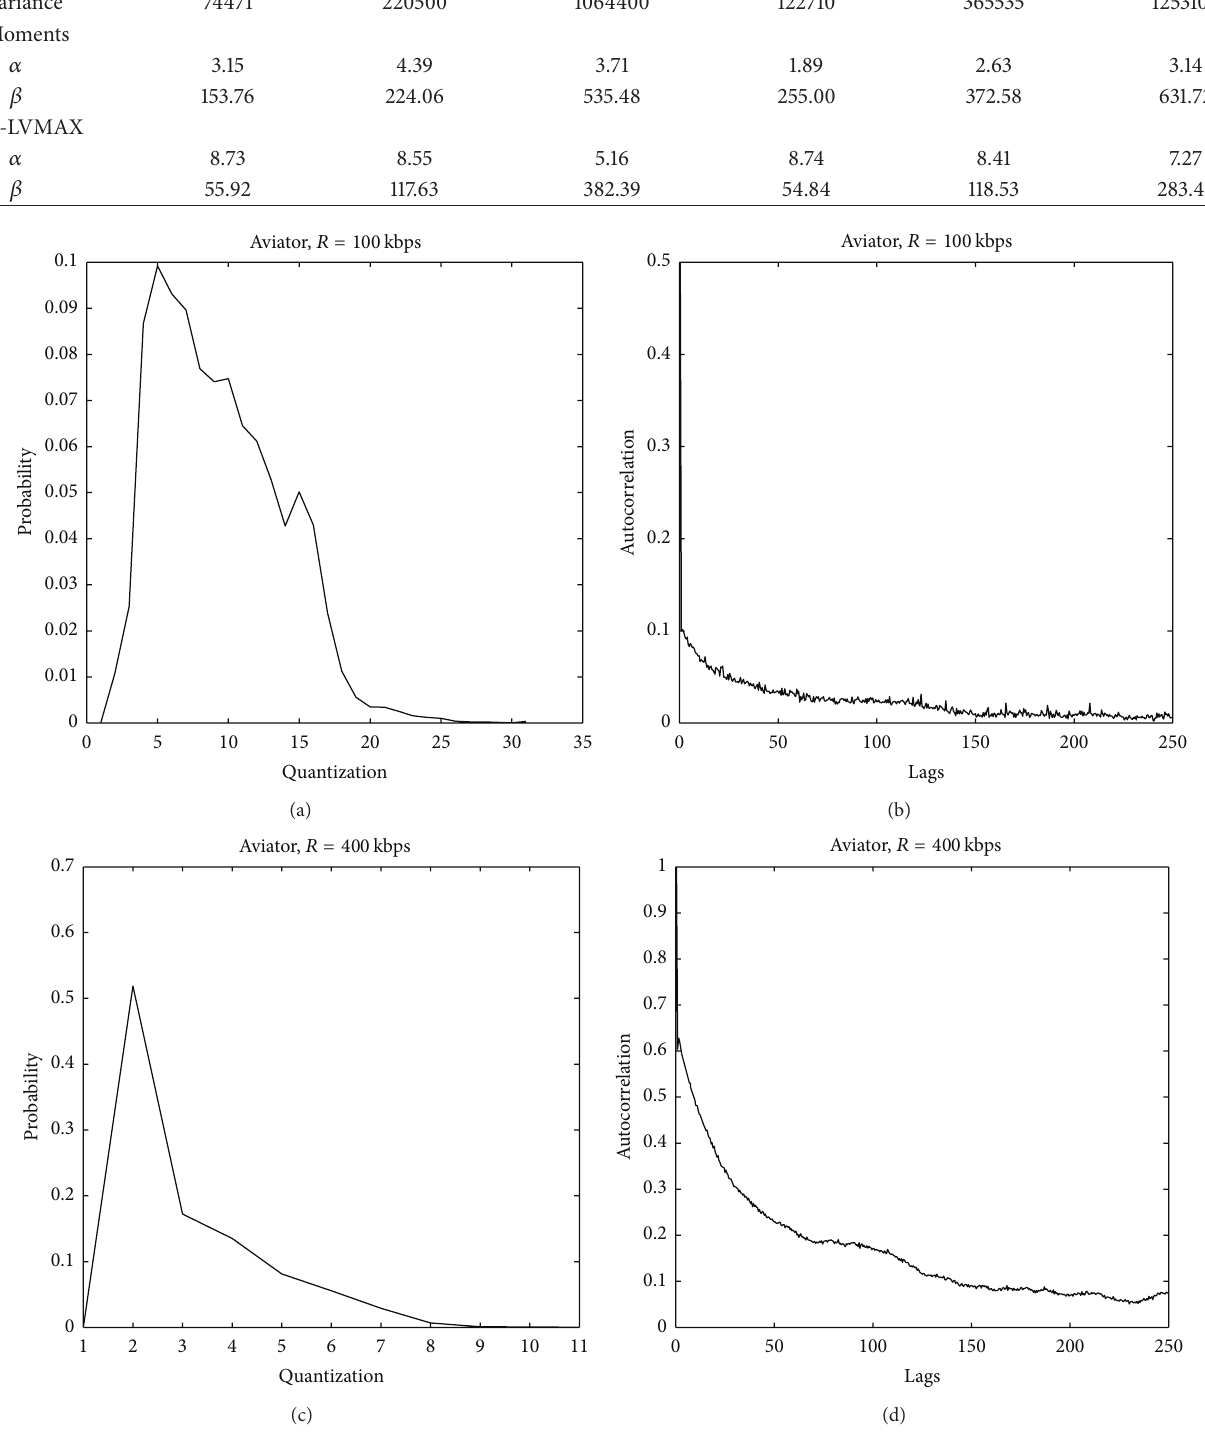
Figure 5: Constrained traffic, quantization histograms, and autocorrelation